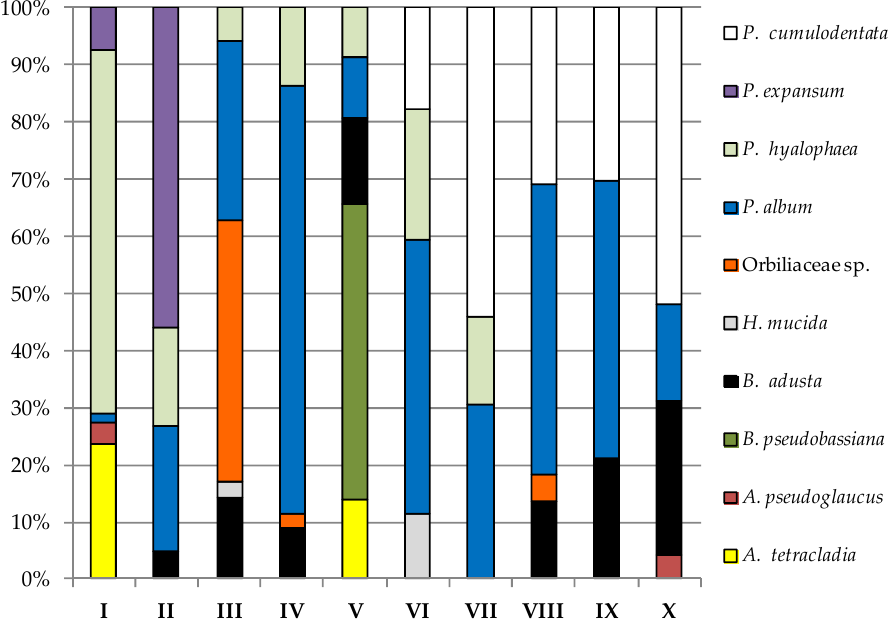
Figure 4. Percentage of each fungus contributing to the total fungi cultured on PDA from the cryoconite holes in the Werenskiold Glacier (Spitsbergen) at 7 °C from study sites I to X.